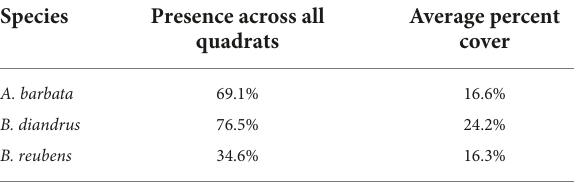
TABLE 2 Three most common exotic